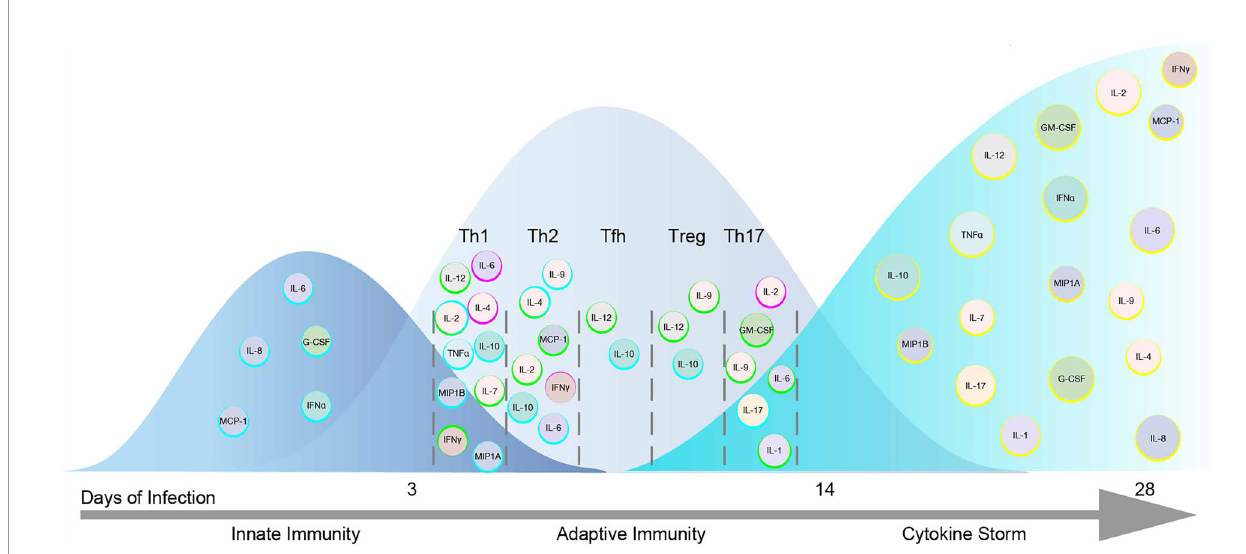
FIGURE 2 | Cytokines within the Storm are Depicted in the Immunological Response to SARS-CoV-2 Infection. A model of the immunological response to SARS- CoV-2 infection displaying cytokines within the storm including those that signal by JAKs and STATs. Cytokines are placed in the immunological timeline based on their expected role in innate and adaptive responses to SARS-CoV-2 infection. Cytokines enhancing immune function are outlined in blue. Cytokines promoting Th differentiation are outlined in green while those inhibiting Th differentiation are outlined in fuchsia. Cytokines are later shown during the COVID-19 cytokine storm outlined in